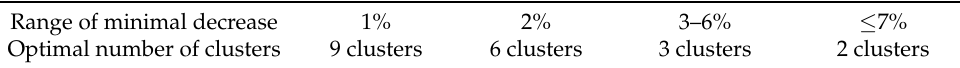
Table 3. The calculations of minimal decrease for v-fold cross-validation test results. Range of minimal